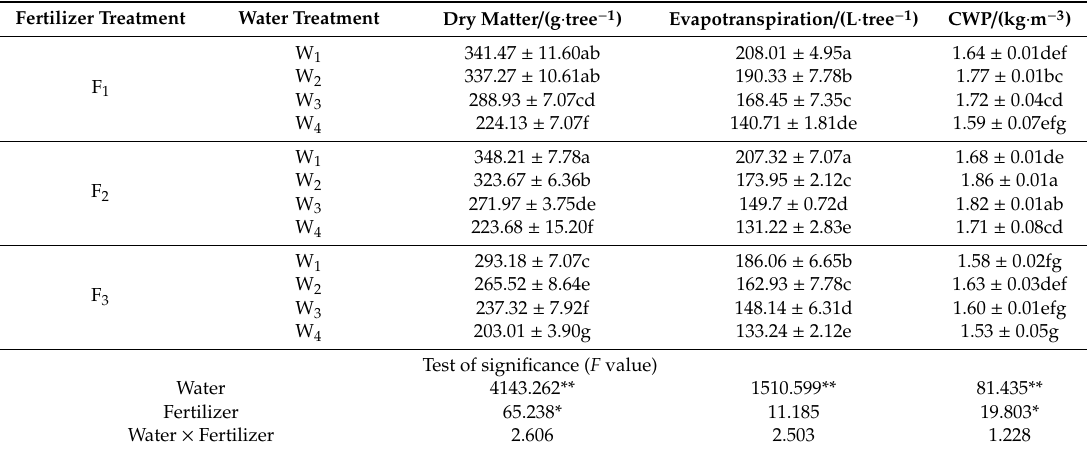
Table 2. E ff ects of di ff erent water and fertilizer treatments on dry matter, evapotranspiration and crop water productivity (CWP) of young apple trees in